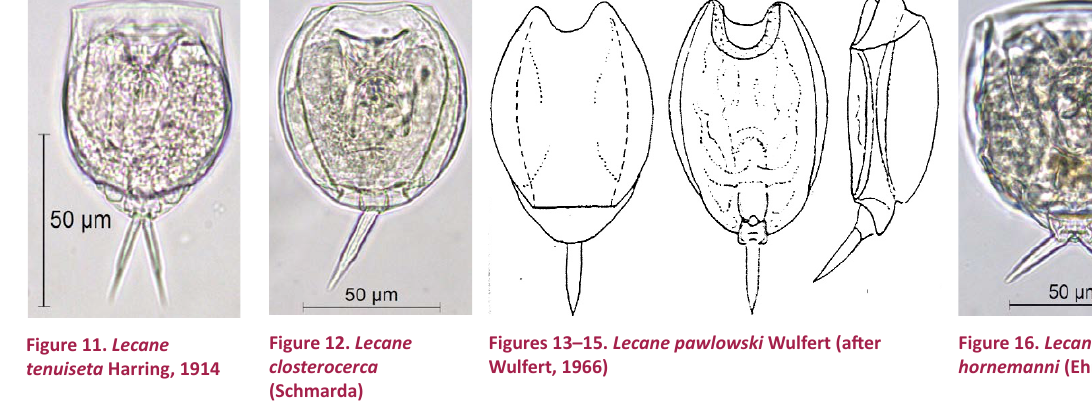
Figure 11. Lecane tenuiseta Harring, 1914